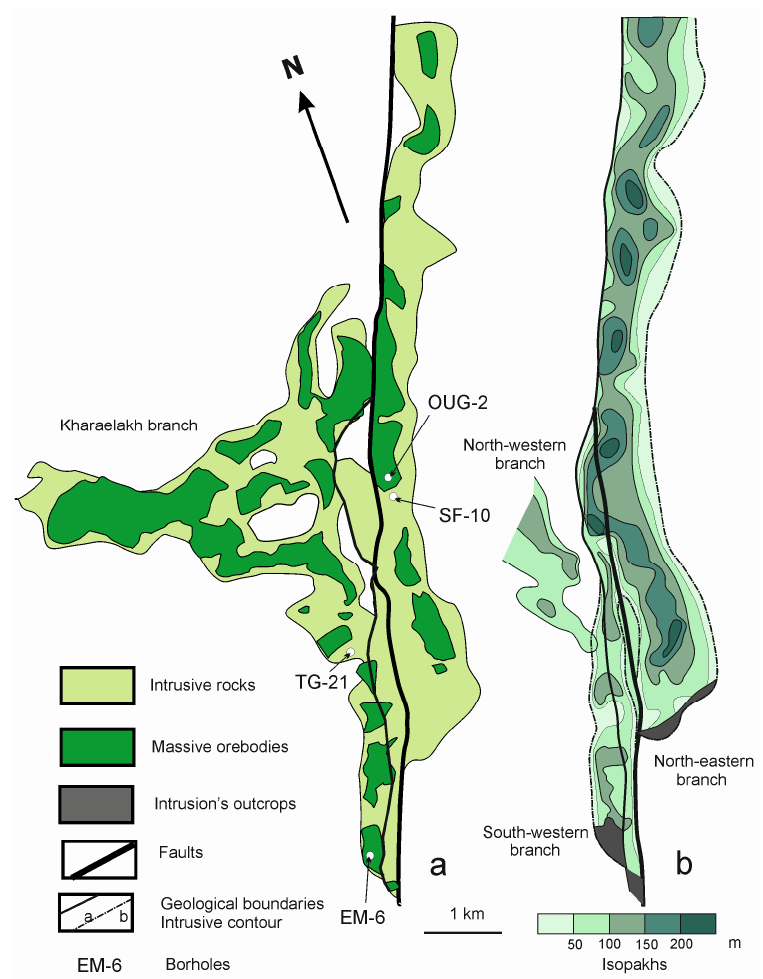
Figure 2. Position of the orebodies ( a ) (after Natorkhin et al., Turovtsev [65,66]). Projection on the surface; ( b ) (after Geology of Ore Deposits [69]) and isopach map of the Talnakh intrusion with studied boreholes.